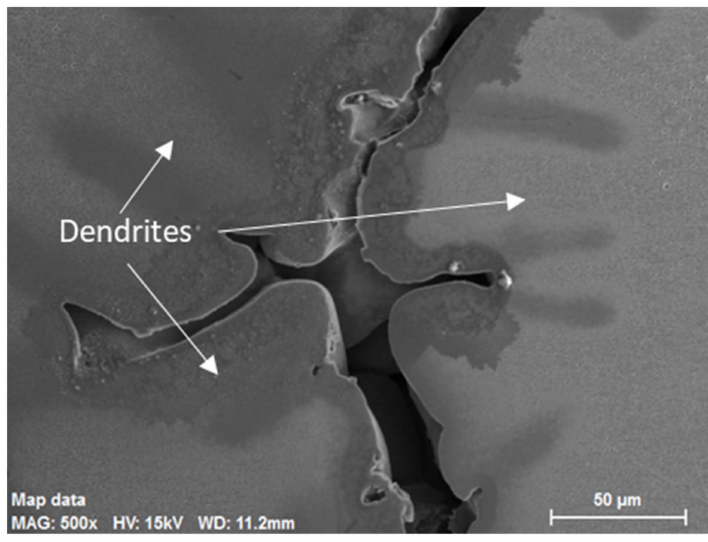
Figure 8. Porosity between dendrites, close to the center.